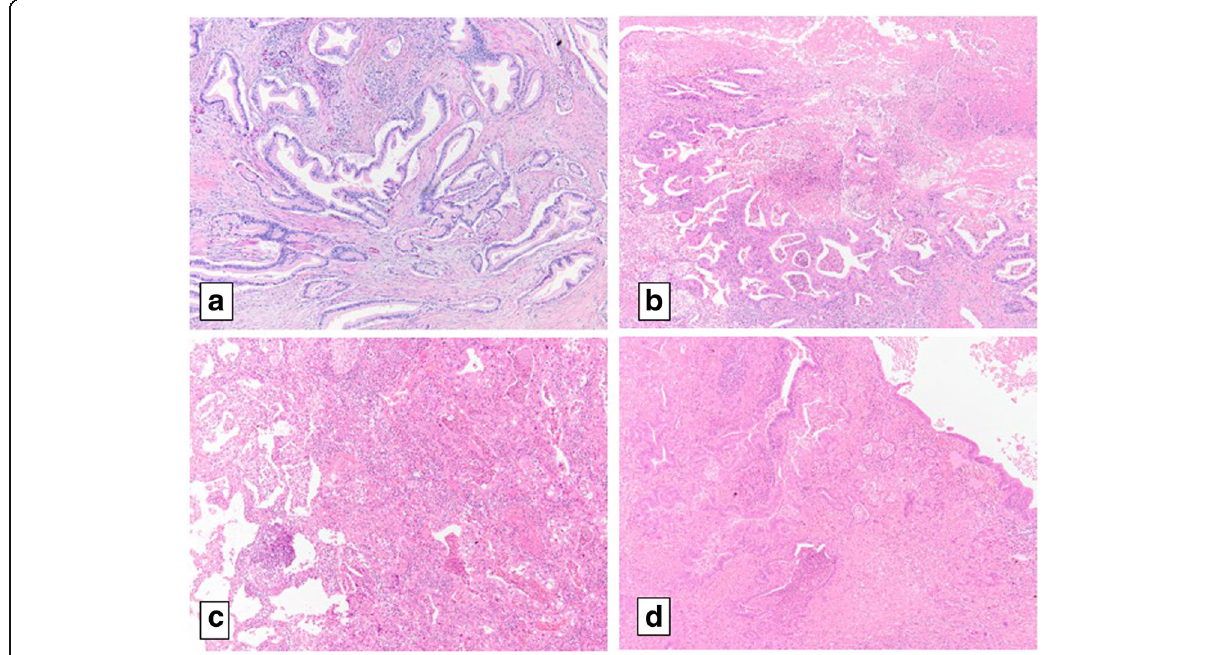
Fig. 4 Histopathology. a Microscopic view of the primary tumor. b Microscopic view of the first pulmonary metastatic tumor. c Microscopic view of the second pulmonary metastatic tumor. d Microscopic view of the third pulmonary metastatic tumor. Histologically, all of the metastatic tumors are composed of columnar cancer cells with papillotubular proliferation. These findings are similar to those of the primary